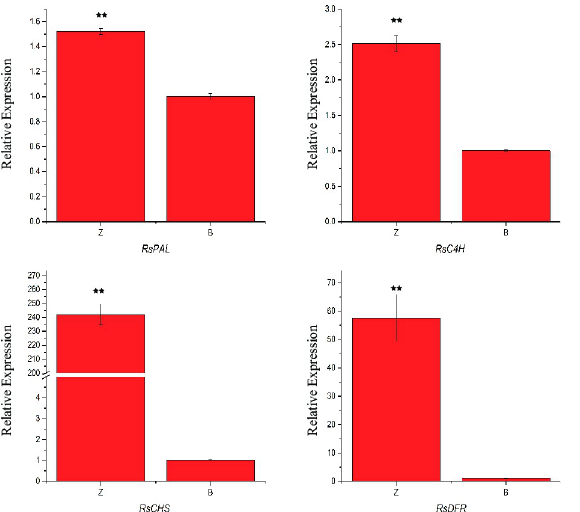
Fig 4. qRT-PCR analysis of the transcript expression levels of the RsPAL , RsC4H , RsCHS and RsDFR genes between dark red and white radish taproots. Error bars indicate standard deviations for three biological replicates. �� reveals significantly different with P <